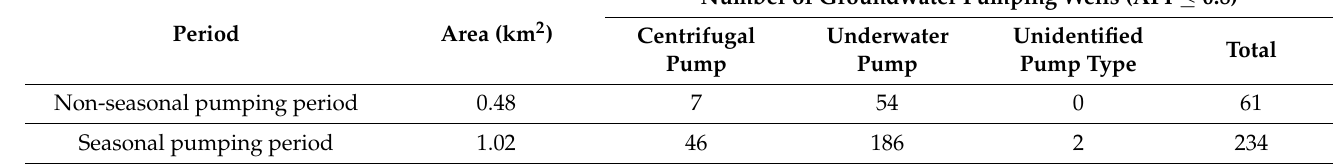
Table 4. Number of groundwater pumping wells experiencing difficulty due to the opening of the weir (API ≤